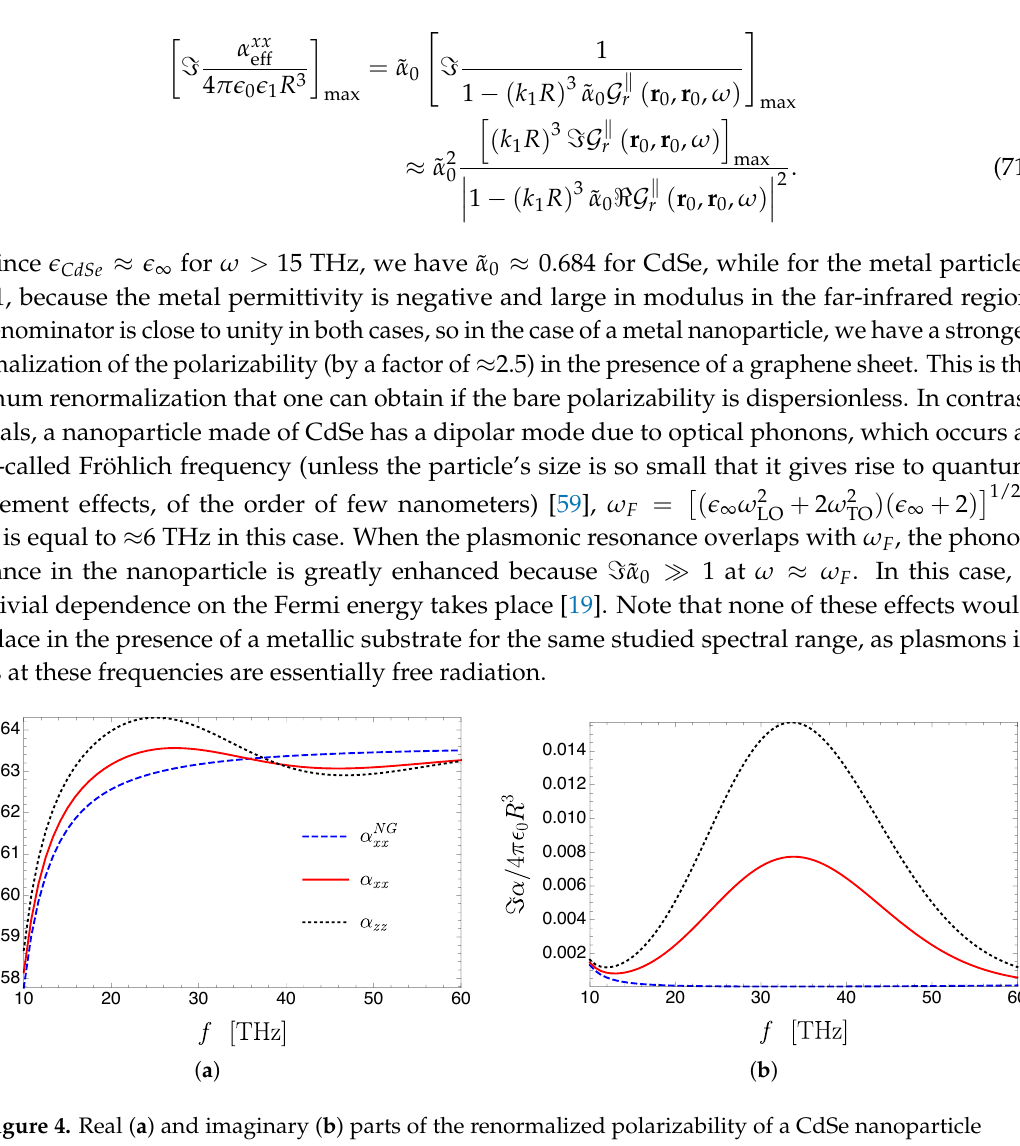
Figure 4. Real ( a ) and imaginary ( b ) parts of the renormalized polarizability of a CdSe nanoparticle with R = 50nm located at a distance of z 0 = 151nm from a graphene sheet with a Fermi energy of 1 eV and damping parameter of ¯ h γ = 4.1 meV, supported by a dielectric of permittivity (cid:101) 2 = 2. The solid red line represents the xx component of the polarizability, and the black dotted line represents the zz component. The dashed blue line is the xx component of the polarizability in the absence of graphene. The parameters used in both panels for the Lorentz model for the dielectric function of CdSe are: (cid:101) ∞ = 6.2, ω LO = 211 cm − 1 , ω TO = 169 cm − 1 and Γ TO = 5 cm − 1